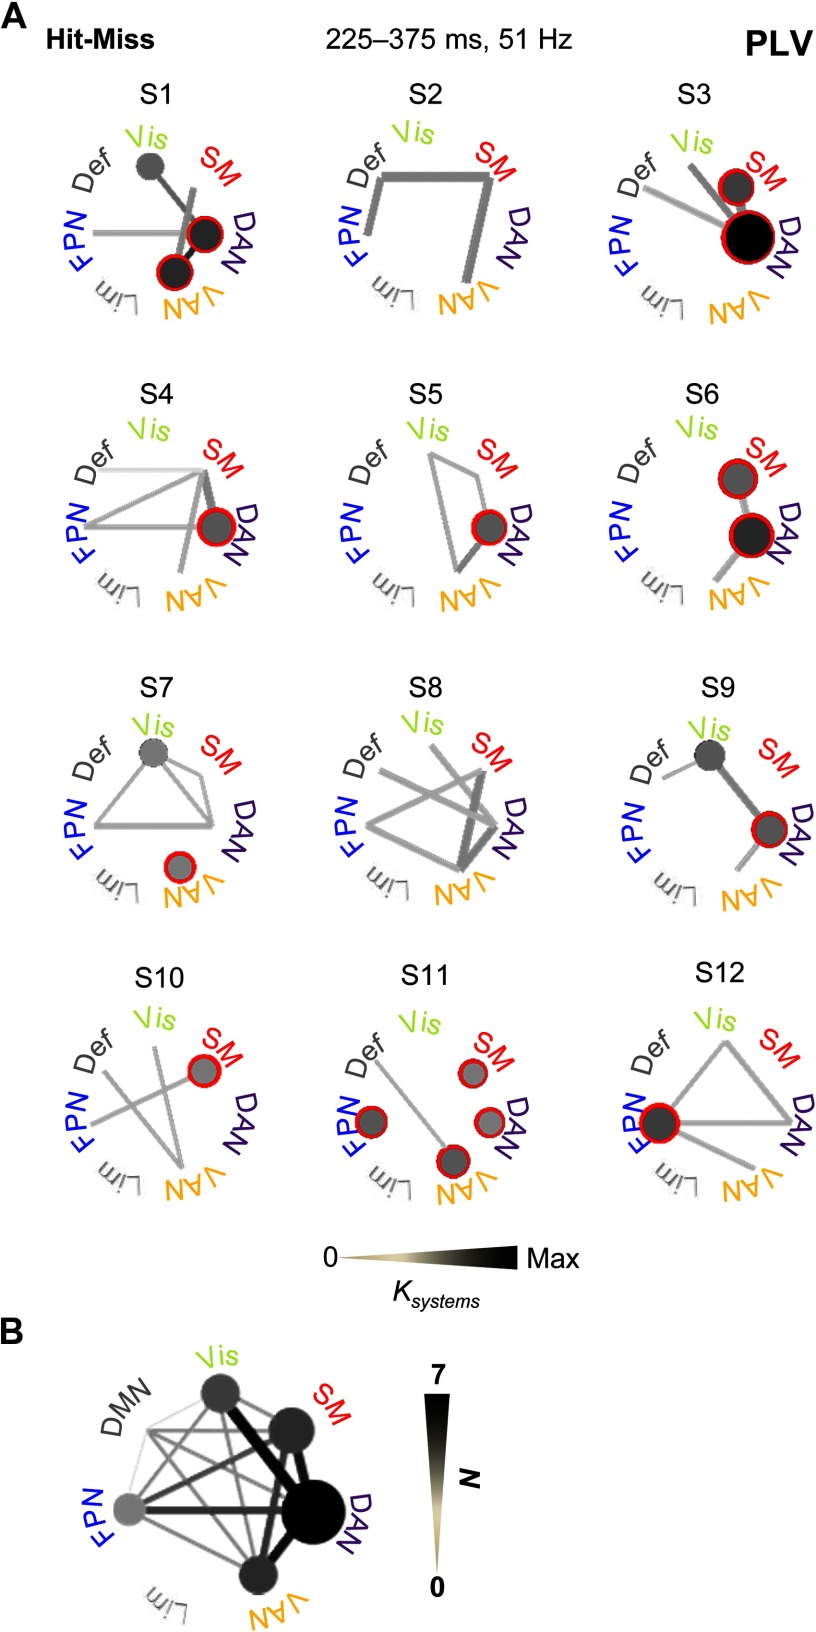
Synchrony within and between attentional and sensorimotor systems is frequently observed in individual subject’s statistical analyses. (A) All significant connections among functional subsystems separately for each subject. Significant connections are shown with gray tone that is scaled relative to the connection density between (lines) or within (circles) the subsystems. Red surroundings indicate the most common within-subsystem connections across the subjects. (B) All significant connections across all subjects in individual subject statistical analyses. Line color indicates the number of subjects (N) in which significant connections were were observed.